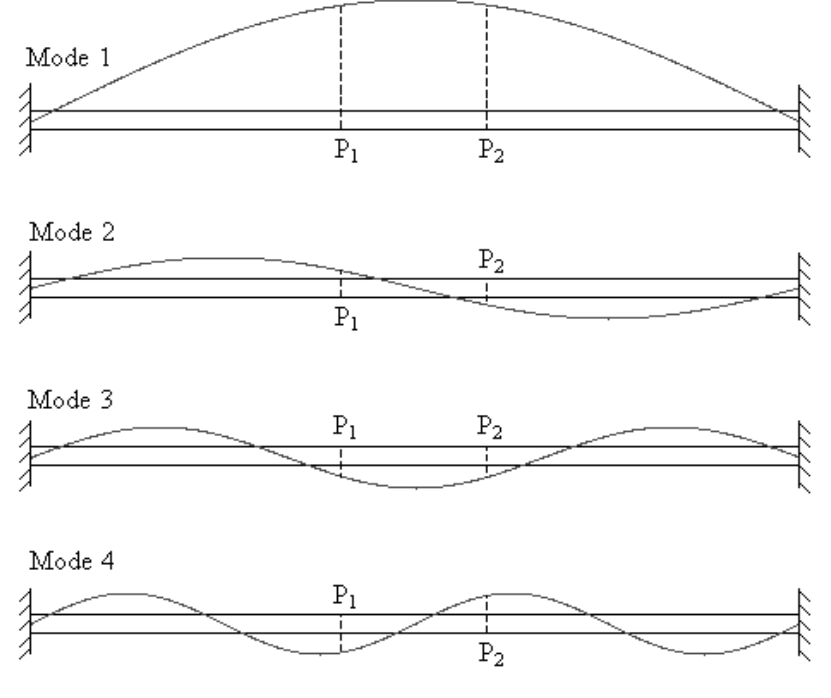
Fig. 4. First four mode shapes of the longitudinally vibrating undamped elastic